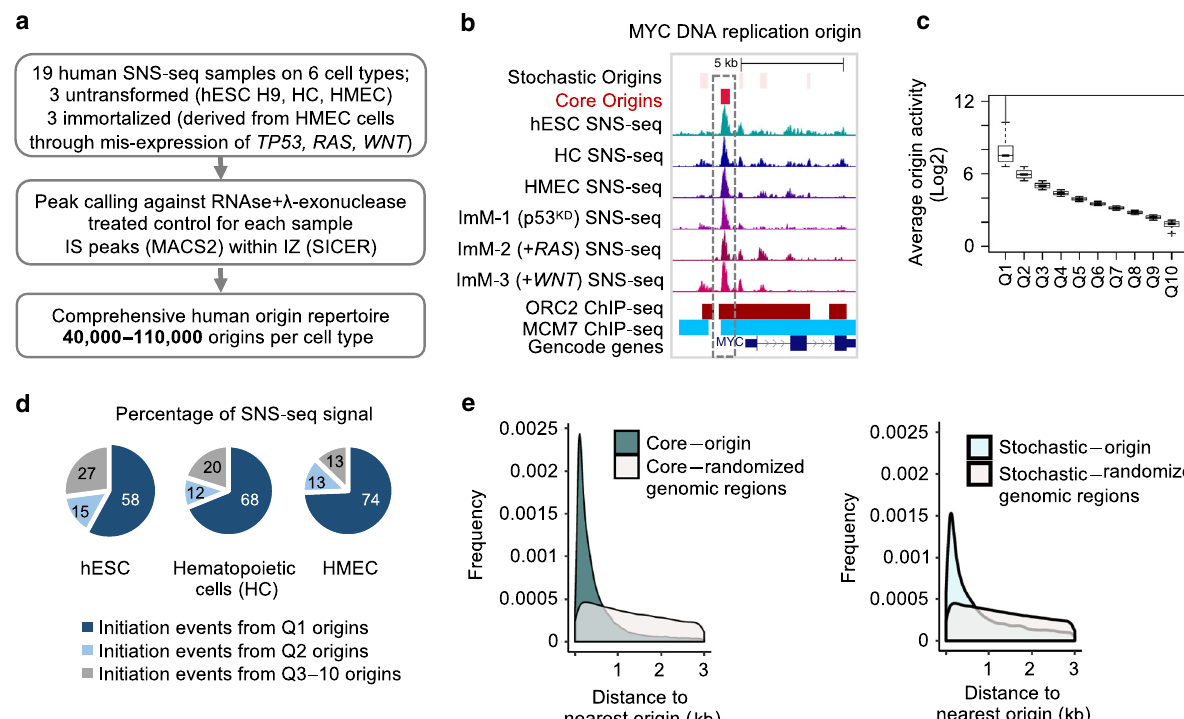
Fig. 1 Human origin repertoire. a Experimental work fl ow. SNS-seq was performed on three untransformed (hESC H9, patient derived hematopoietic cells (HC), and patient derived Human Mammary Epithelial Cells (HMEC), and three immortalised cell types (total n = 19). Immortalised cells were obtained through a reduction of TP53 mRNA levels (ImM-1, p53 KD ) or further expression of oncogenes RAS (ImM-2, + RAS) or WNT (ImM-3, + WNT) in HMEC cells. b UCSC genome browser snapshot of the human replication origin ( MYC origin) captured by SNS-seq. Representative SNS-seq read-pro fi les, published positions of ORC2- (red) and MCM7-bound (blue) regions and the GENCODE genes (v25) are shown. The positions of origins de fi ned in this study are shown on top; red: high-activity origins (core origins), light pink: low-activity origins (stochastic origins). c Boxplot showing the average origin activity (normalised SNS-seq counts across all samples, in Log2) per each quantile ( x -axis represents Q1-Q10 origins). Line within the boxplot represents median, whereas the bounds of the box de fi ne the fi rst and third quartiles. Bottom and top of whiskers represent minimum and maximum numbers respectively for each boxplot. d Q1 and Q2 origins host the overwhelming majority of initiation events in untransformed cell types. Pie chart representing the percentage of DNA replication initiation events (normalised SNS-seq counts) that originate from Q1, Q2 or Q3-10 origins in the indicated untransformed cell types. e Density plots showing the distribution of the distances to nearest origin ( x -axis, in Kb) for core origins (left panel) and stochastic origins (right panel). In grey are control density plots that show the distribution of the distances between core/stochastic origins to the nearest randomised genomic region of the same size and number as origins. Both frequency plots were signi fi cantly different from randomised distributions ( p